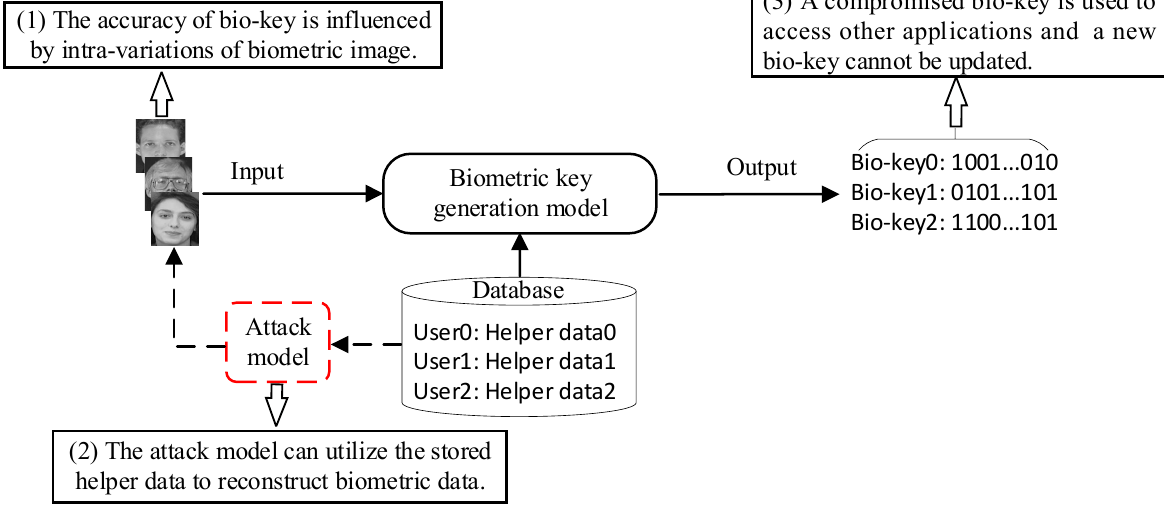
Figure 1. Illustration of security, privacy, and accuracy issues in the biometric key generation methods.